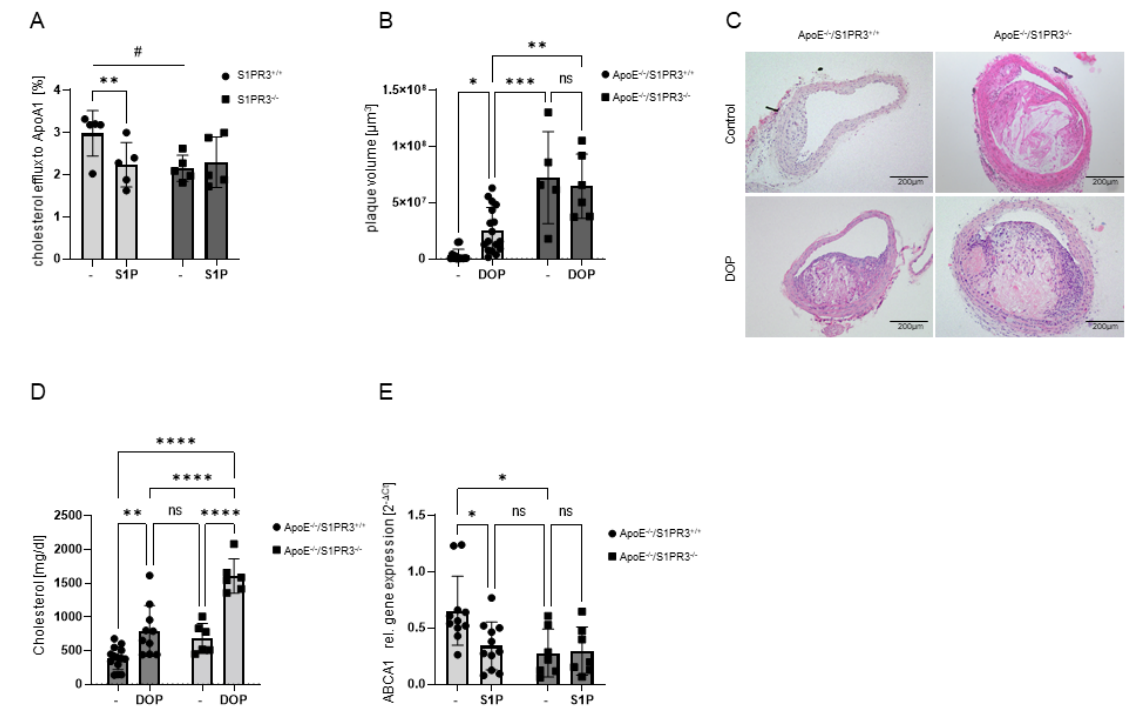
Figure 7. Macrophage cholesterol efflux and ABCA1 gene expression, plasma cholesterol, and atherosclerosis in S1PR3 deficient mice. ( A ) [ 3 H]-cholesterol efflux to ApoA-I with and without 1 µ M S1P added 30 min prior to ApoA-I and measured after 5 h in S1PR +/+ and S1PR3 − / − mice. ( B ) Quantification of plaque volume in the brachiocephalic artery after 12 weeks of Western versus Western-B6+DOP diet using Cavalieri’s stereologic method. ( C ) Representative images from ( B ). ( D ) Plasma cholesterol levels after 12 weeks of Western versus Western-B6+DOP diet in ApoE − / − and ApoE − / − /S1PR3 − / − mice. ( E ) Macrophage ABCA1 gene expression with and without 1 µ M S1P stimulation for 6 h in ApoE − / − /S1PR +/+ and ApoE − / − /S1PR3 − / − mice. Data in ( A , B ) are presented as mean ± SD and tested with stack matched two-way ANOVA (# for comparing genotypes; * for comparing treatments); # p < 0.05; ** p < 0.01; *** p < 0.001). Data in ( D , E ) are presented as mean ± SD and tested with two-way ANOVA; ns = not significant; ** p < 0.01; **** p <